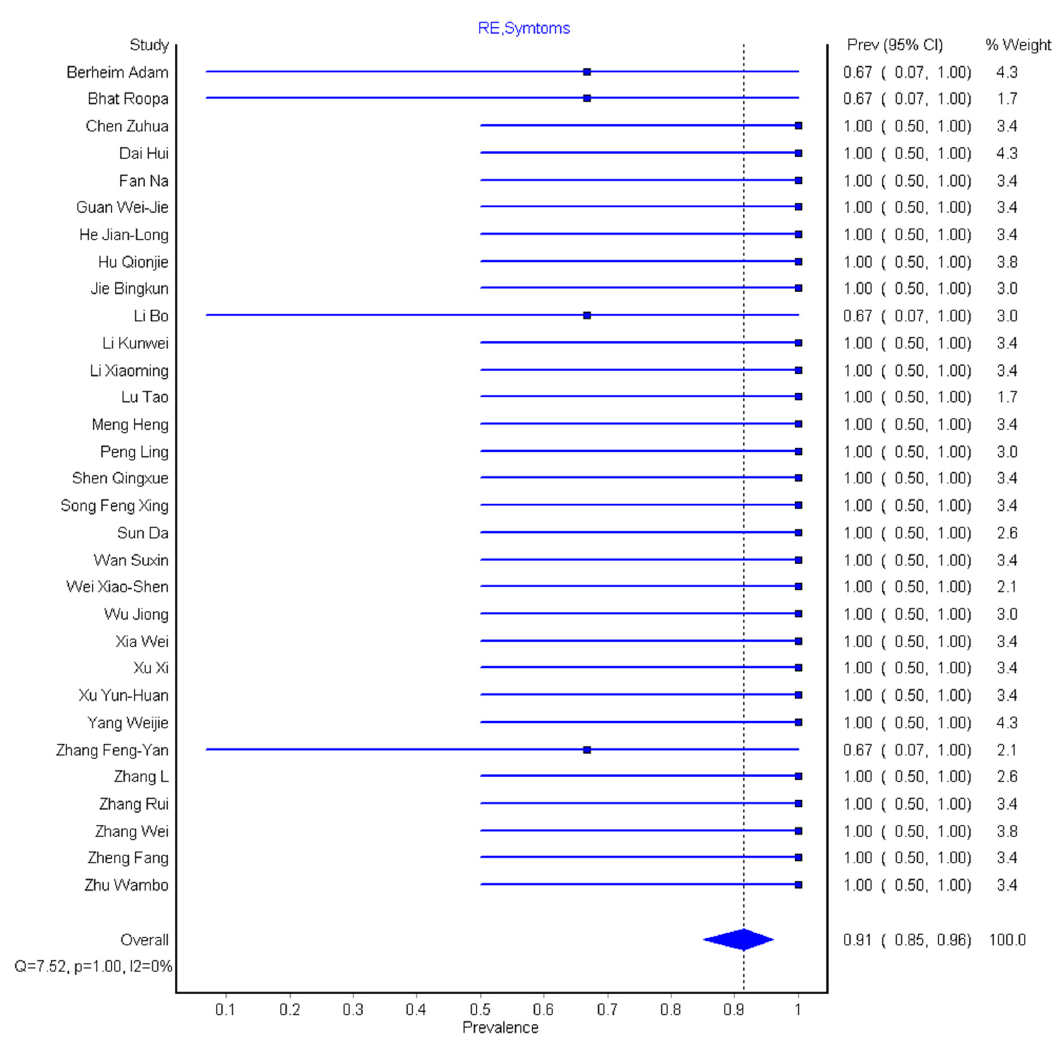
Figure 6. Forest plot of the pooled prevalence of grouped clinical symptoms (i.e., mild, moderate, and severe